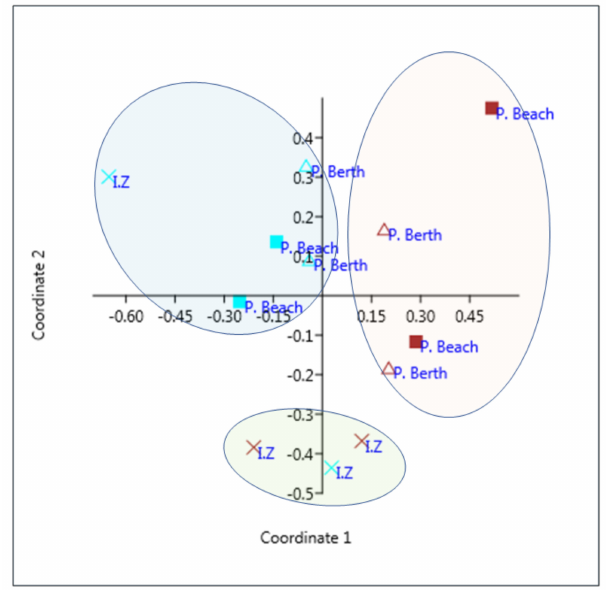
Figure 10. Principal coordinates analysis plot (PCoA) based on a Euclidean distance matrix calculated of the mucus bacterial community and the surrounding seawater. (Brown marks represent coral mucus samples and blue marks represent seawater samples) [X: Industrial zone samples, (cid:4) : Public Beach samples, ∆ : Phosphate Berth samples].